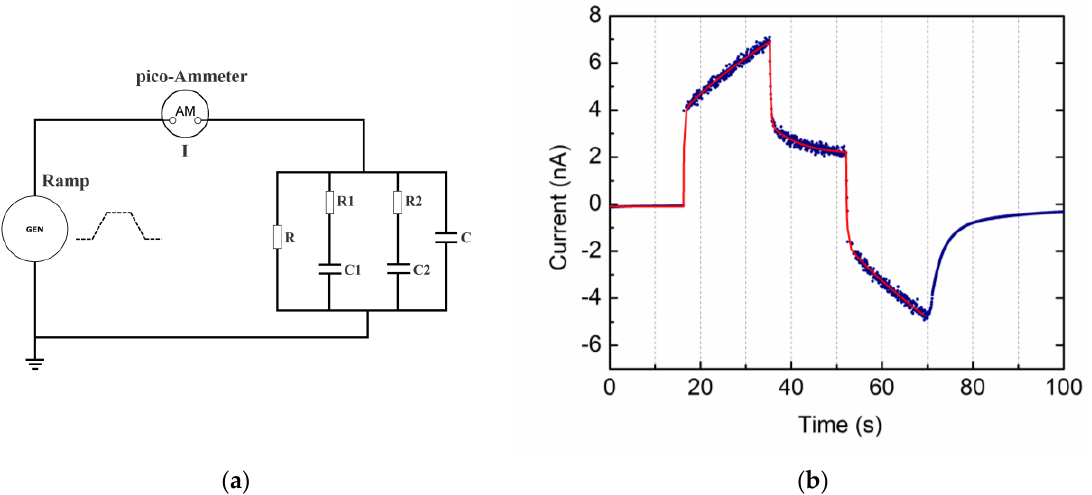
Figure 6. VRM method applied to a 540 μm thick quartz slice. The input voltage ramp-up/down is 25 V/s and the top value is 500 V; ( a ) schematic of the electrical circuit used for the analytical model. Two relaxation times have been added to the standard R-C circuit in order to take into account the current decrease after the flat top voltage is reached; ( b ) the shape of the current output (blue marks) shows a loss due to the finite resistance of the material during the voltage ramp-up and ramp-down. An analytical function (red line) for the current has been used to fit the data.